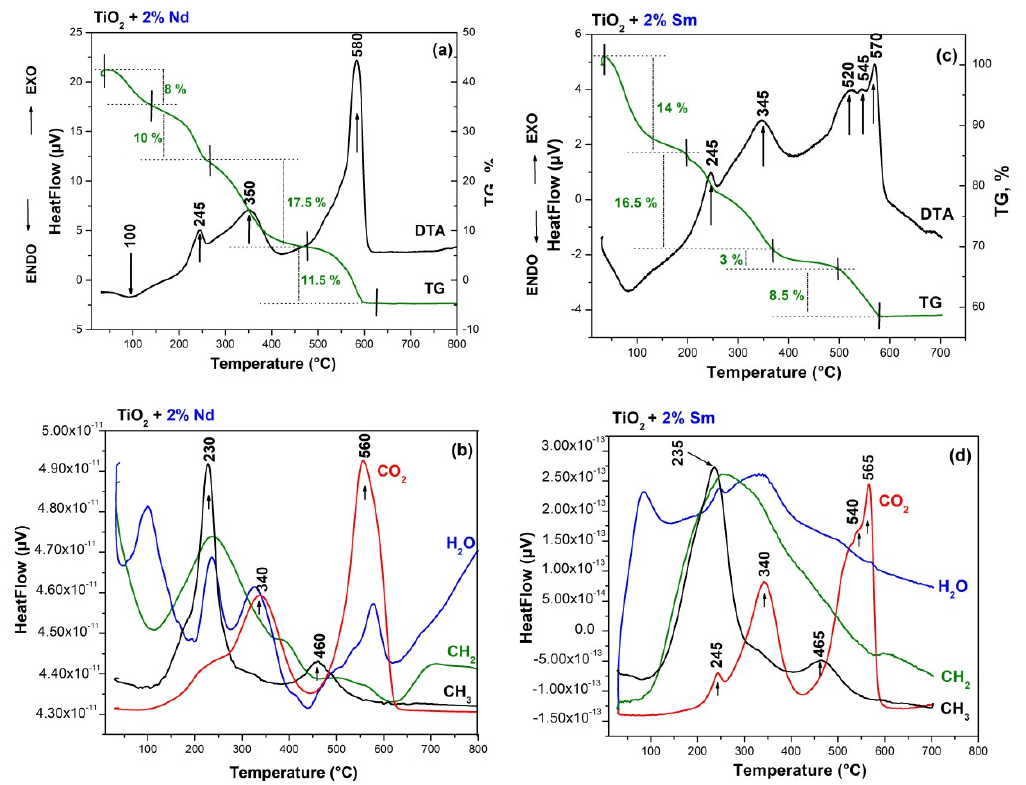
Figure 4. Differential thermal analysis (DTA)/thermogravimetric (TG) curves of the TN) ( a , b ) and TS ( c , d ) samples.